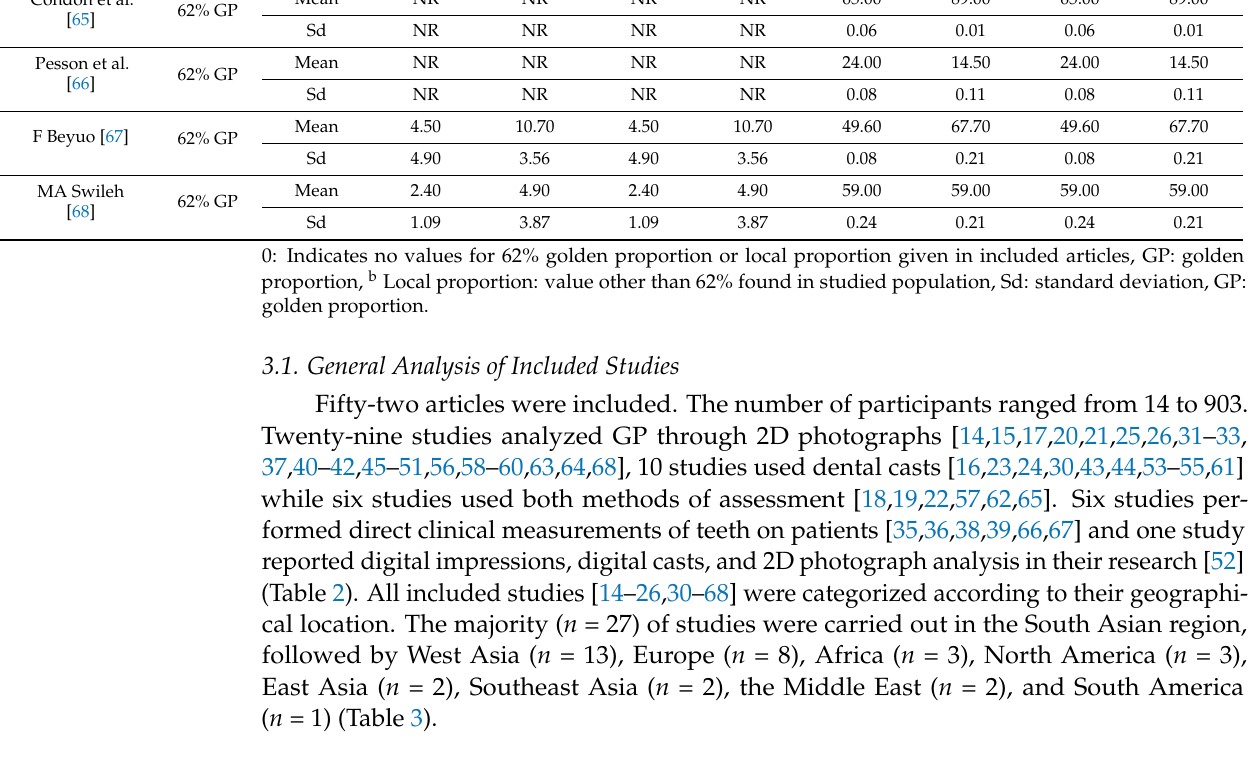
Table 2. Study characteristics of included articles ( n =